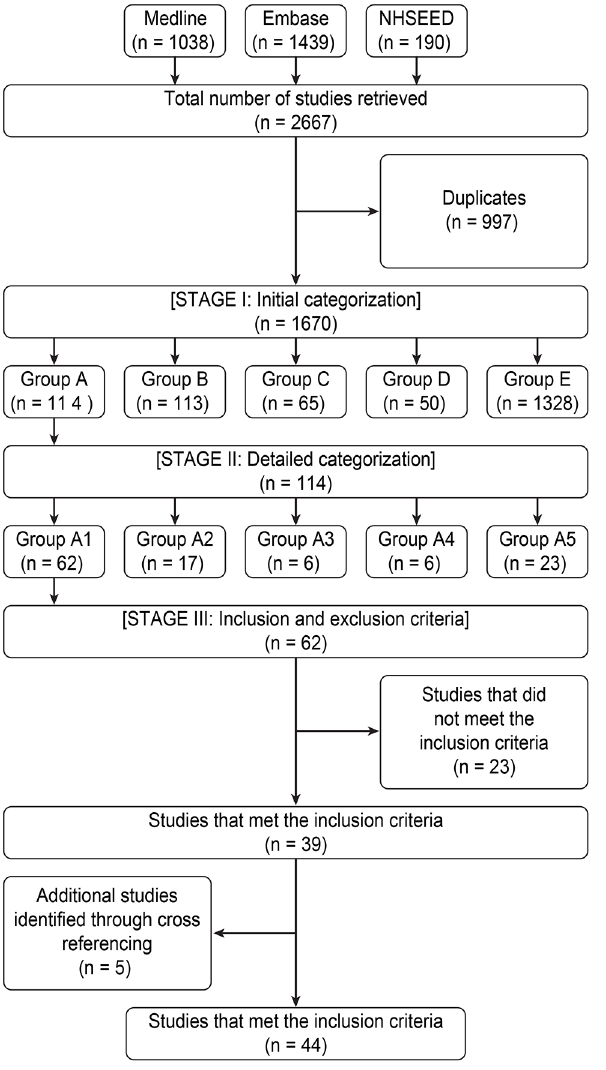
Fig 1. Literature search and